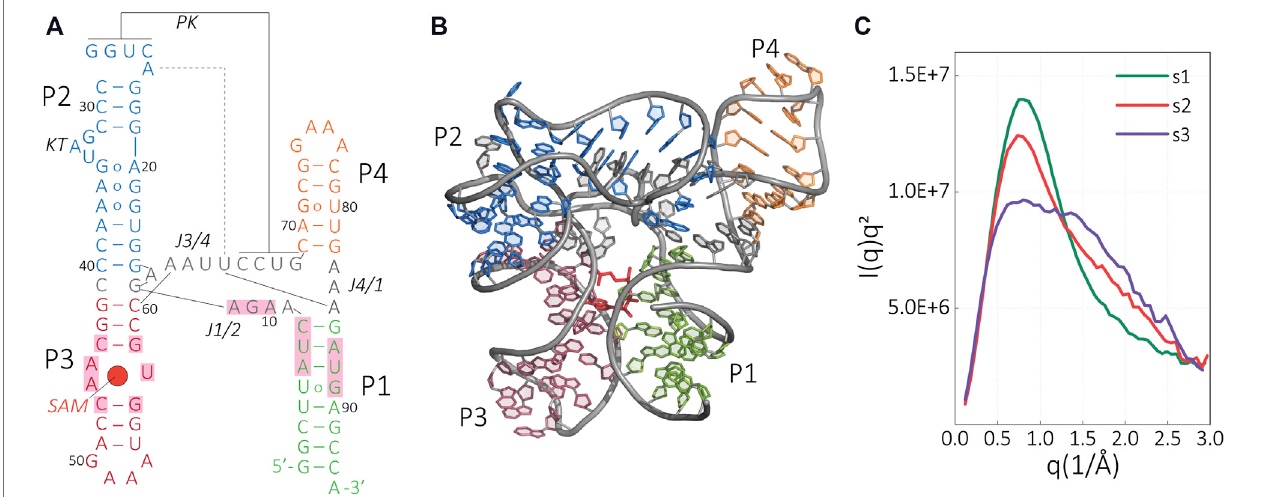
FIGURE2 | Structure and scatteringpro fi le of SAM-I riboswitch aptamer. (A) Secondaryand (B) tertiary structureof theligand-bound SAM-Iaptamer. Key tertiary interactions are labeled as follows: P, paired; J, joining; KT, kink-turn; and PK, pseudoknot. The helices P1 – P4 are colored in the tertiary structure according to the secondary structure representation. The ligand SAM is colored in red, and the SAM-binding residues are shaded in light red. (C) Kratky representation of the experimental scattering data that were used as a target structure for the SAXS-driven MD of the riboswitch under different con fi gurations [s1: SAM(+),Mg 2+ (+); s2: SAM( − ), Mg 2+ (+); s3: SAM( − ), Mg 2+ ( −